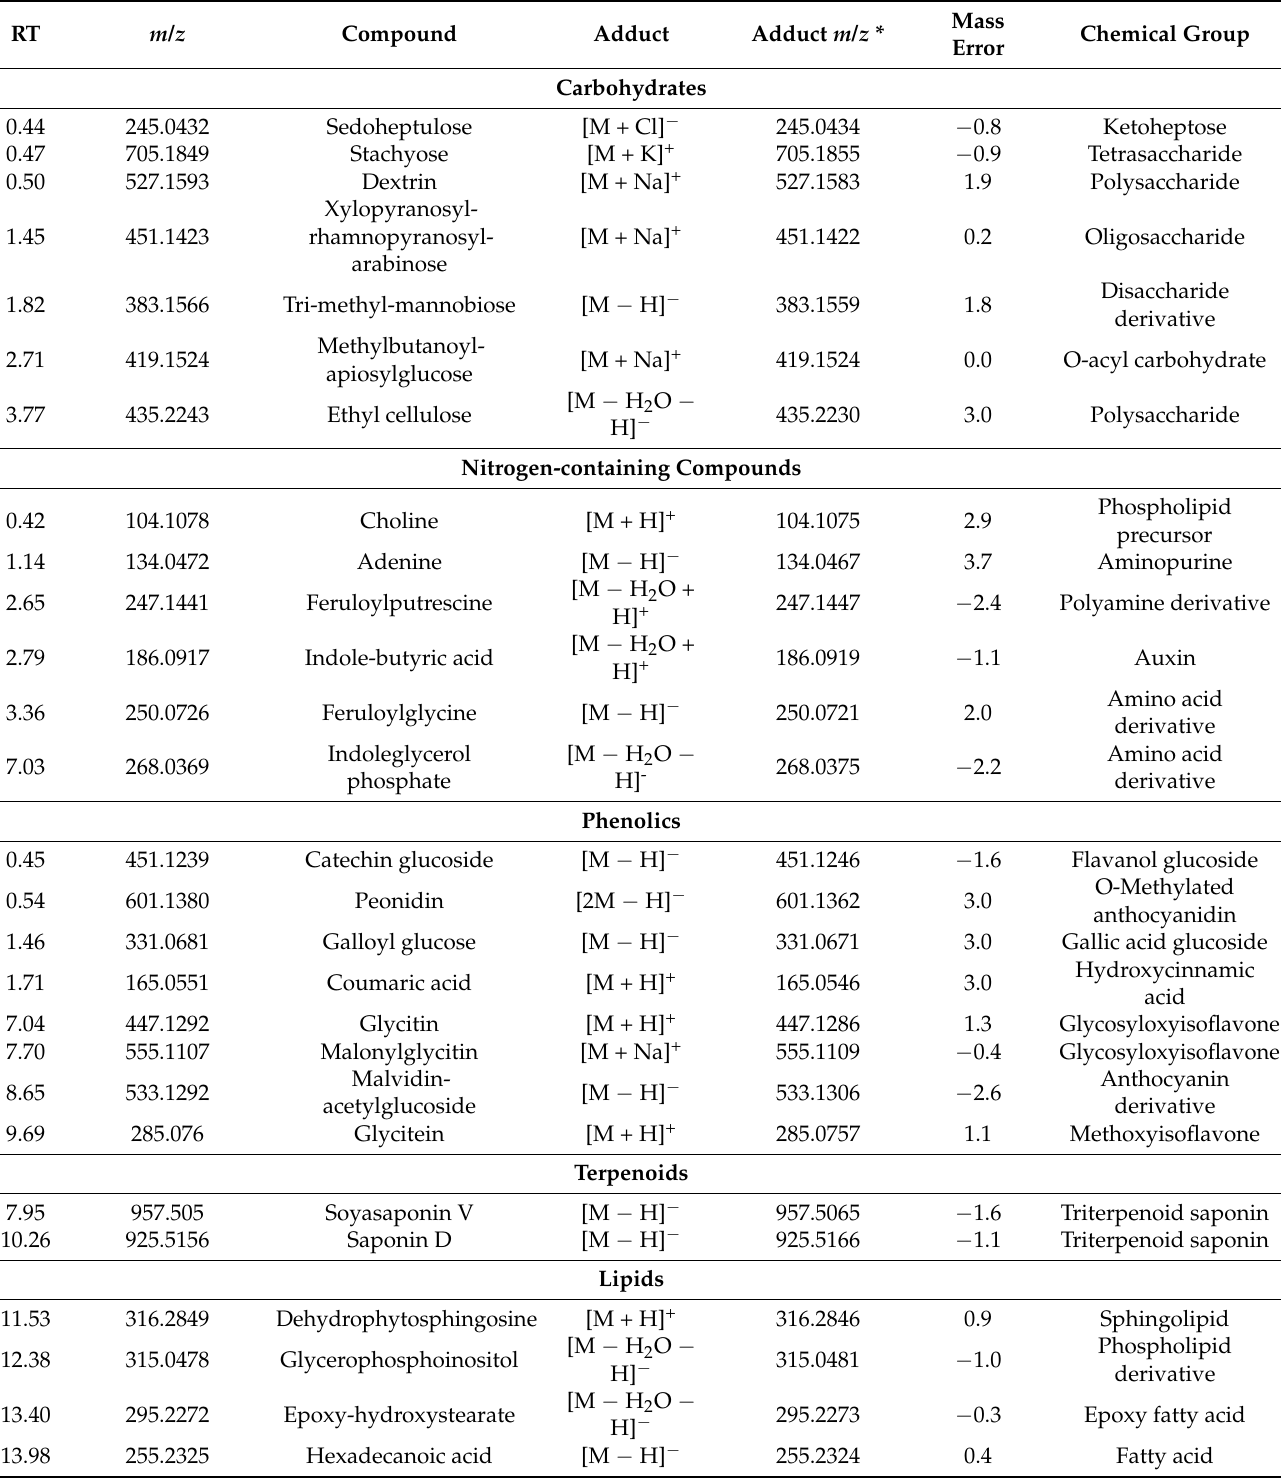
Table 1. Putative identification of compounds only detected in SmallF1 chickpea